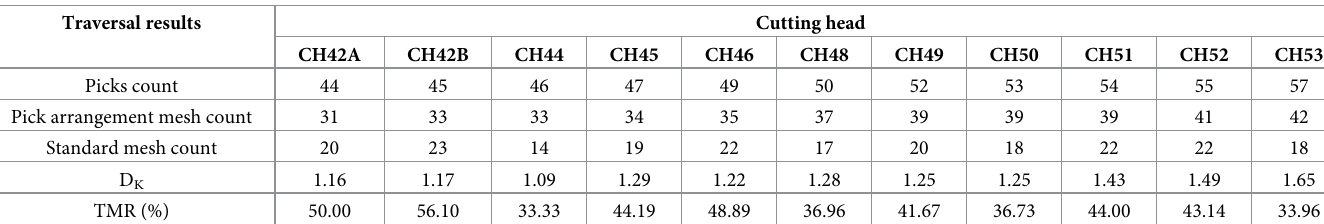
Table 2. Initial traversal